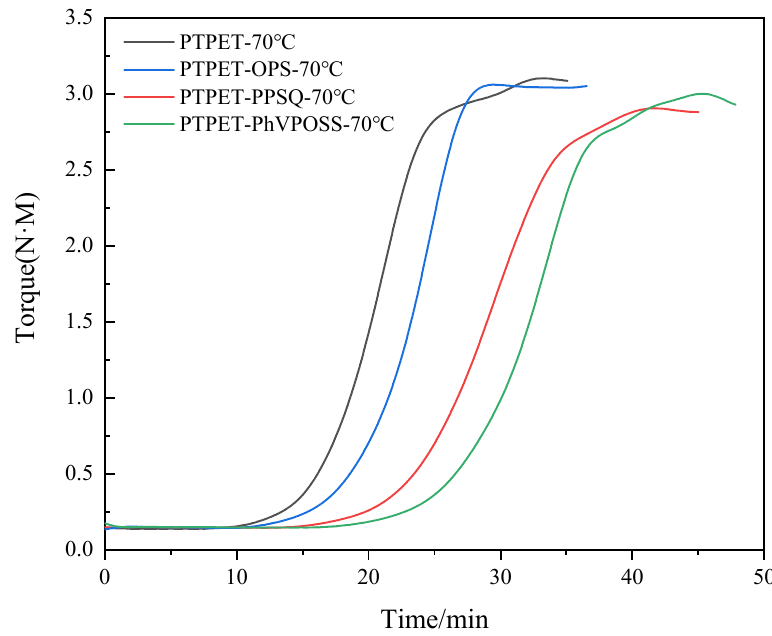
Figure 5. Torque versus time curves of PTPET elastomer and composites at 70 °C.